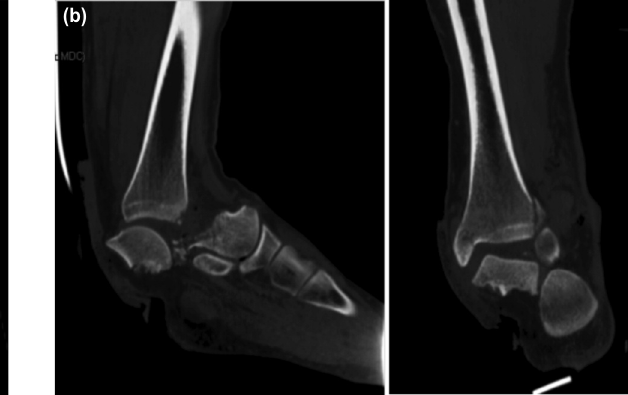
(a) and (b) Pre-operative TC section of both ankles. Fig. 1: